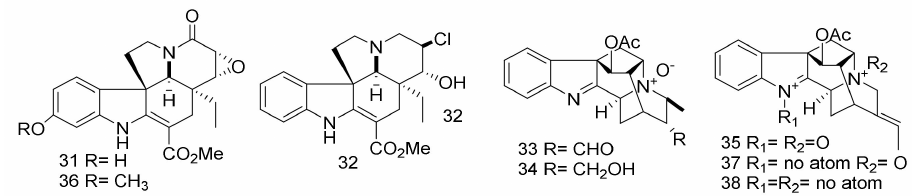
Figure 7. Compounds 31 – 38 .